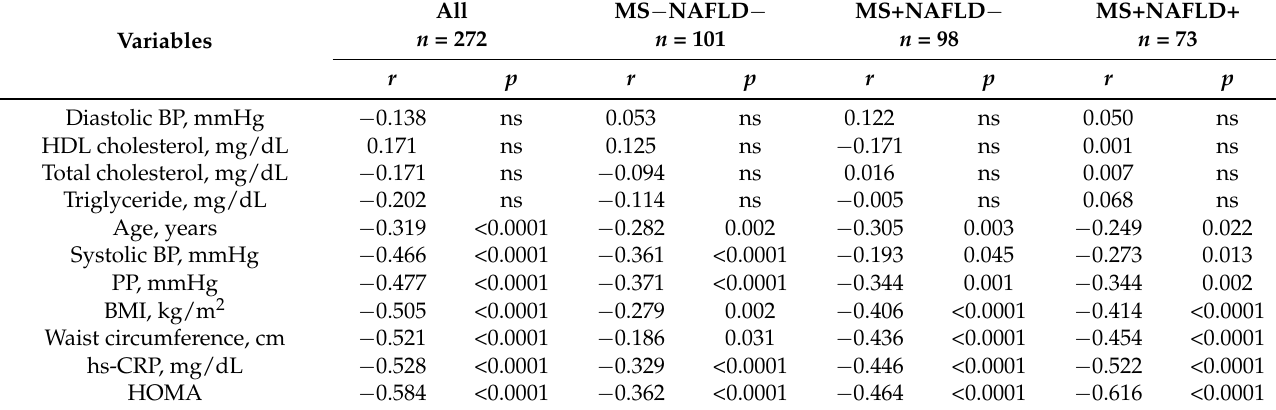
Table 2. Linear regression analysis on forearm blood flow (FBF) as a dependent variable in the whole study population and in different groups.